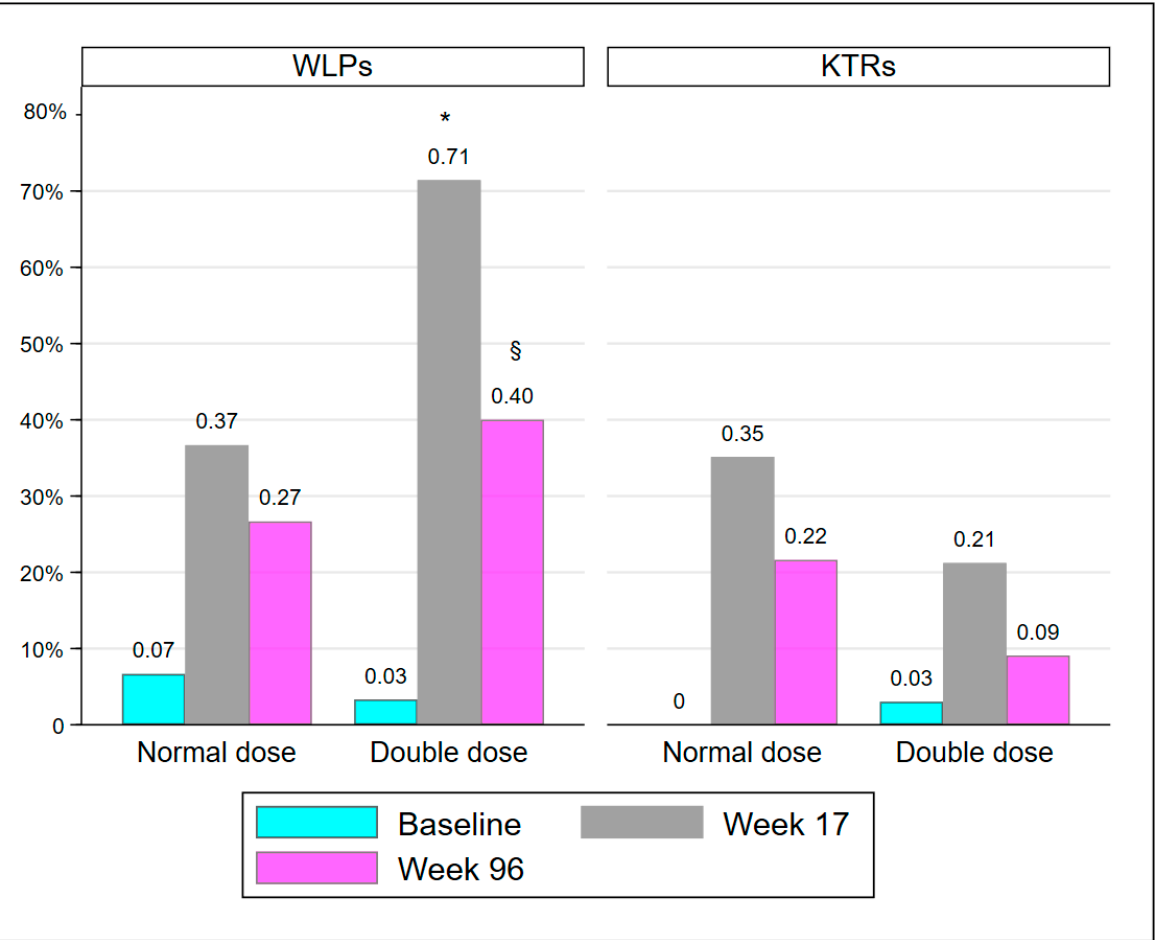
Table 3. Average pneumococcal antibody geometric mean concentrations with 95% confidence intervals at baseline, 17 weeks, and 96 weeks (mg/L). Baseline